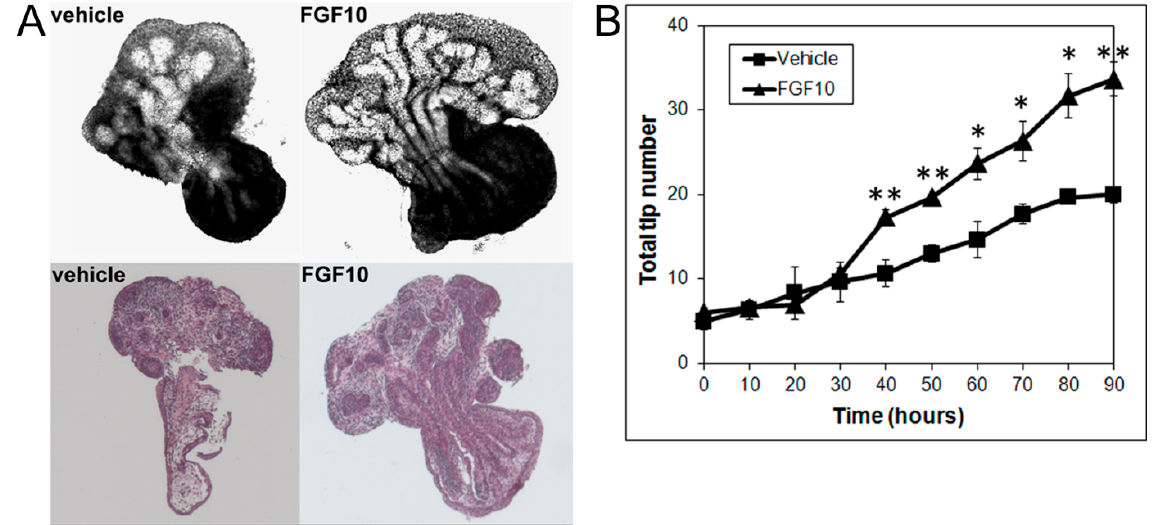
Figure 4. ( A ) Branch generations of contralateral rat pnd 0 LPs cultured for 90 h in the absence (left) or presence of 1 μ g/mL FGF10 (right). Representative end-point images at 90 h are shown (upper panel). H&E staining of corresponding tissues are also shown (lower panel). Note the increased branch formation in 1 μ g/mL FGF10-treated LPs. ( B ) Total tip number in 3D analysis as a function of time in contralateral pnd 0 untreated LPs (squares) and 1 μ g/mL FGF10-treated LPs (triangles) cultured for 90 h. Each data point represents the mean of 4 sets of experiments, and bars denote SEM. * denotes significant differences between vehicle and FGF10 treatment, * p < 0.05, ** p < 0.01.